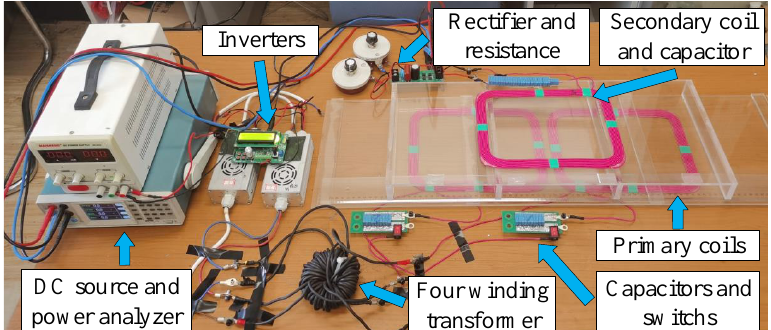
Figure 9. Two-to-one WPT system prototype.